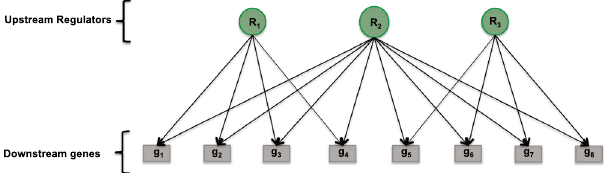
Figure 1. Figure shows a schematic representation of gene sets defined by a regulatory network. The regulators R 1 , R 2 and R 3 group the downstream genes into gene sets g (1) = { g 1 , g 2 , g 3 , g 4 }, g (2) = { g 1 , g 2 , g 3 , g 4 , g 5 , g 6 , g 7 , g 8 } and g (3) = { g 5 , g 6 , g 7 , g 8 }. Note that the gene sets may